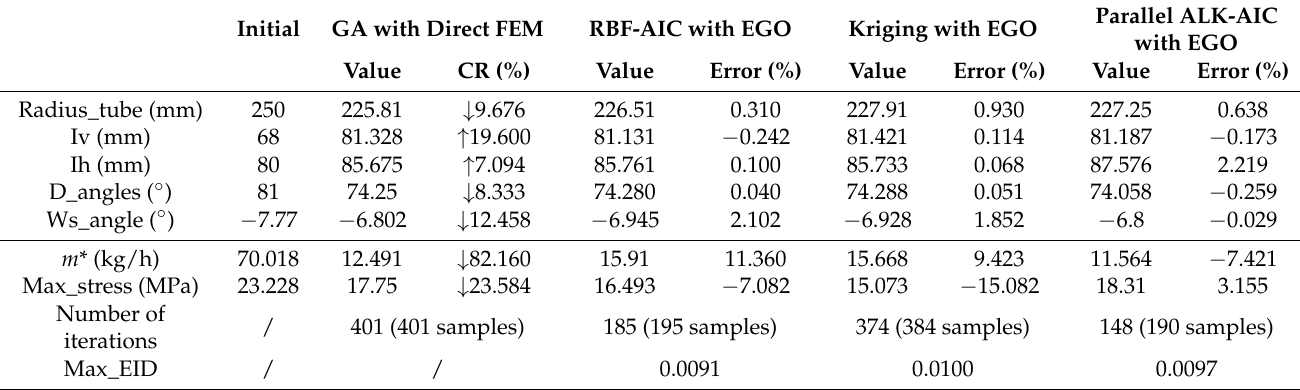
Table 4. The comparison between the initial and optimal